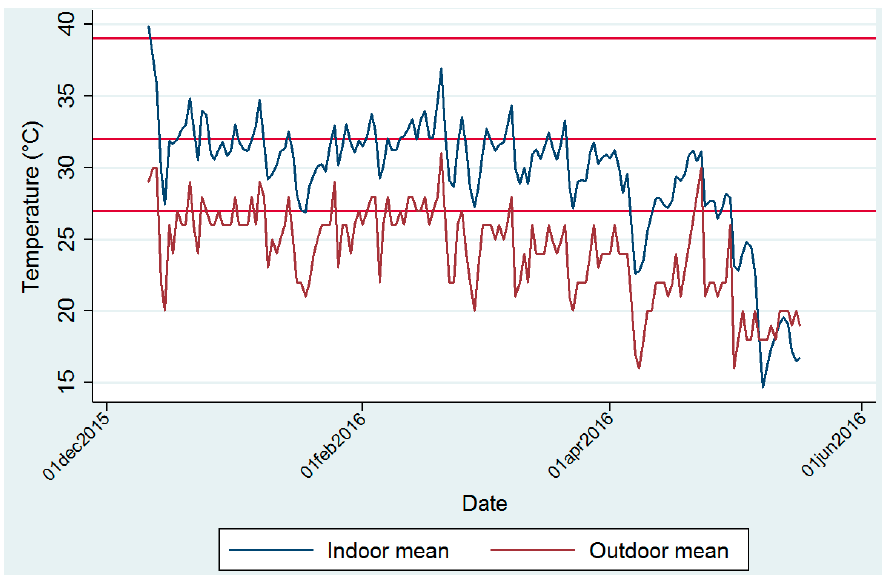
Figure 5. Daily mean indoor apparent temperature and outdoor temperature with superimposed threshold bands as described in Table 2.